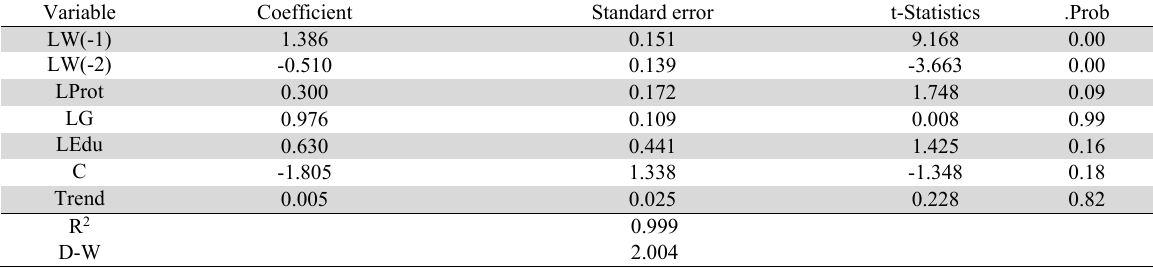
Investigating the short-run relationship between total productivity and wages with time trend Variable Coefficient Standard error